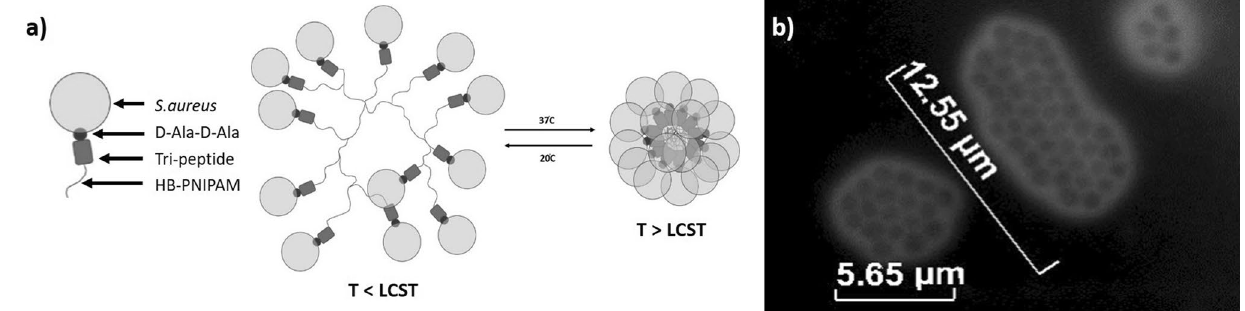
Figure 1. Showing ( a ) Schematic of S. aureus -Van-HB-PNIPAM above (left) and below (right) the LCST exhibiting contraction during its desolvation phase shift and ( b ) Fluorescence microscope image showing S. aureus -Van-HB-PNIPAM at T > LCST stained with